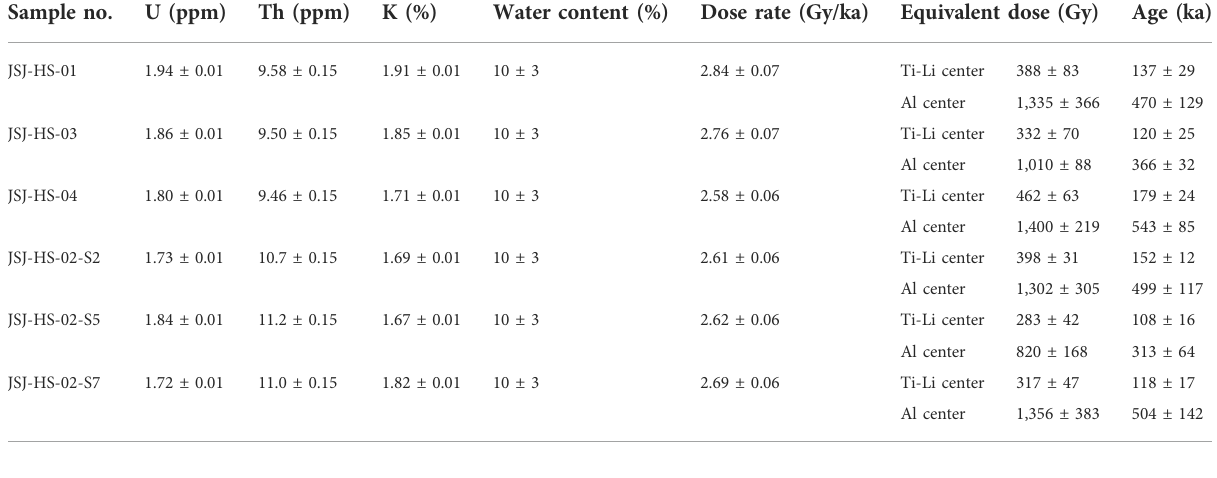
TABLE 3 ESR dating results of diluvia from Baige dammed lake. Sample no.